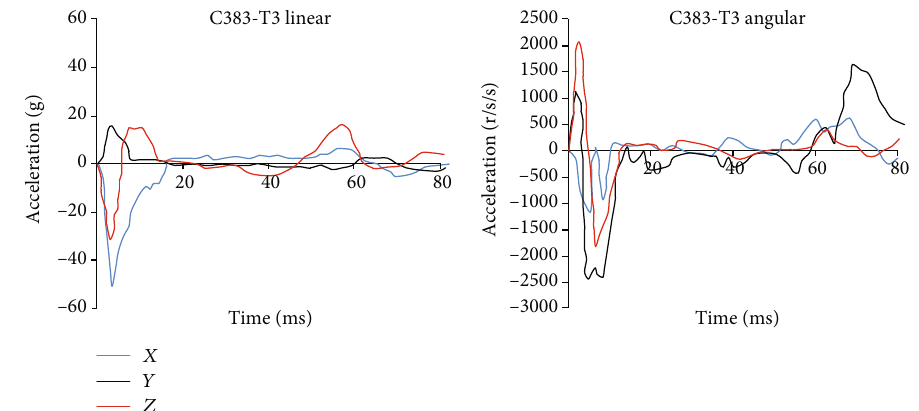
Figure 3: The linear and angular accelerations of C383-T3 [27].